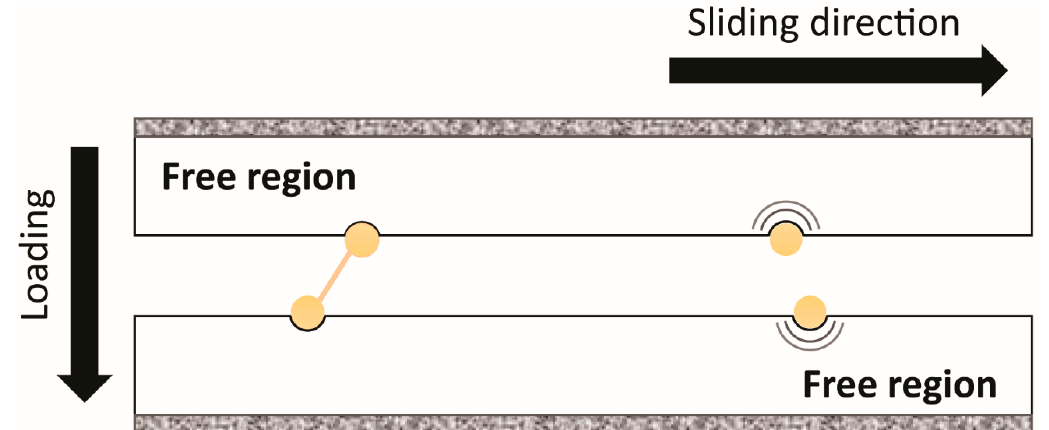
Figure 2. Schematic representation of molecular dynamic simulation of a tribo-contact.